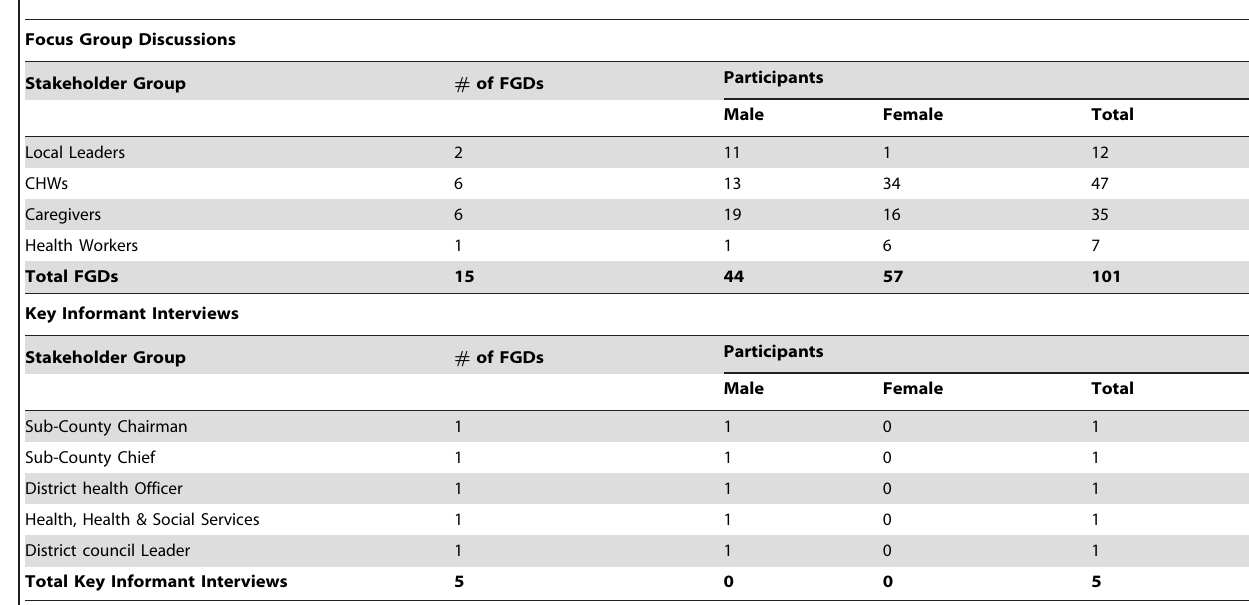
Table 3. Respondents who Participated in Post-Intervention Qualitative Study by Category and